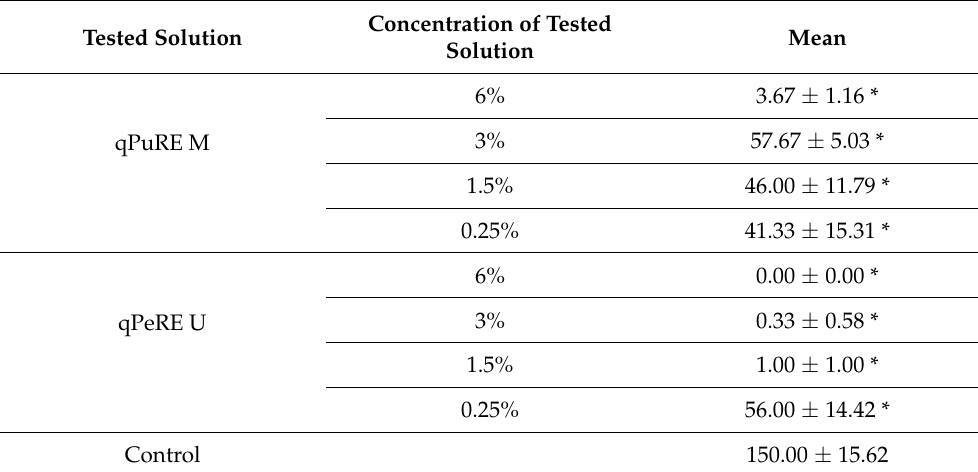
Table 2. The effect of tested solutions on confluent cells after 2 h of incubation. Tested